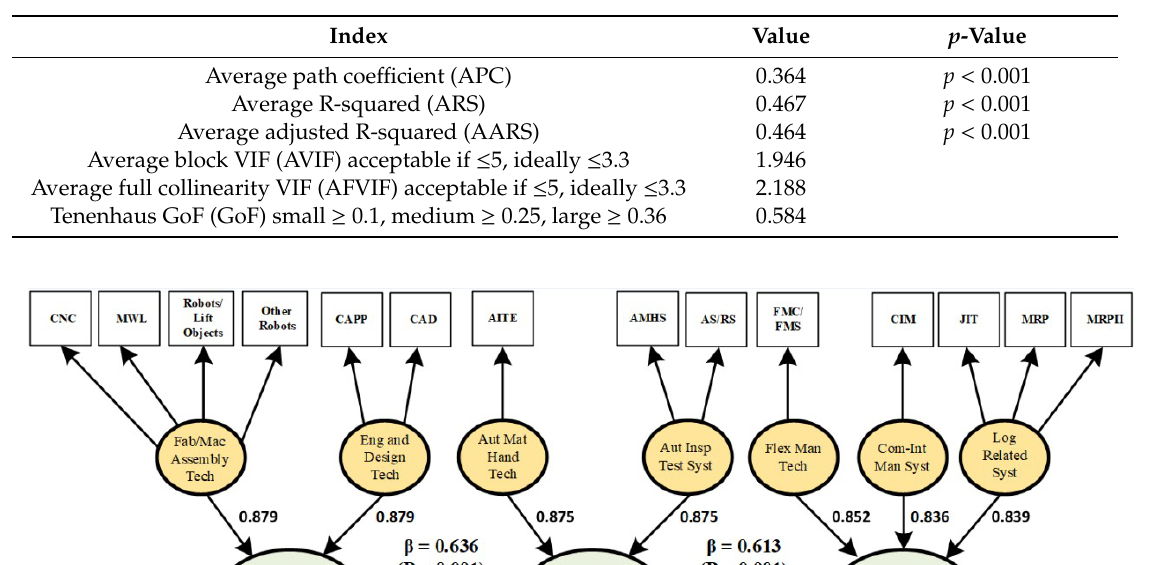
Table 6. Evaluated model and quality indexes.